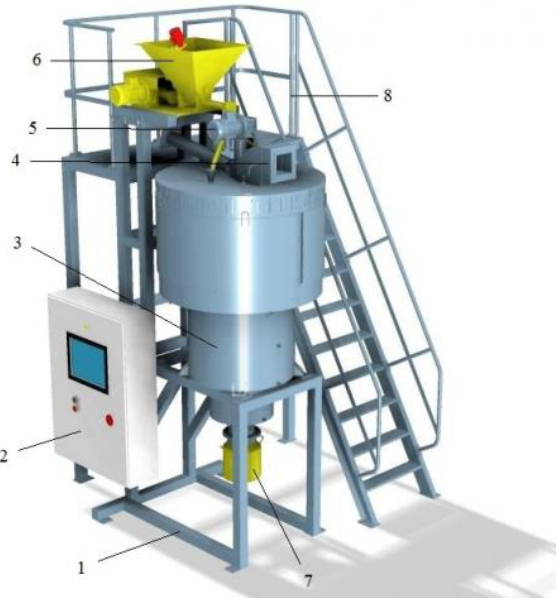
Figure 2. Experimental-industrial centrifugal reactor “TSEFLAR TM ” of the drum type: 1—frame; 2—control board; 3—cooler; 4—air duct; 5—drum drive; 6—tank for raw material; 7—tank for the thermally treated product; 8—processing area.